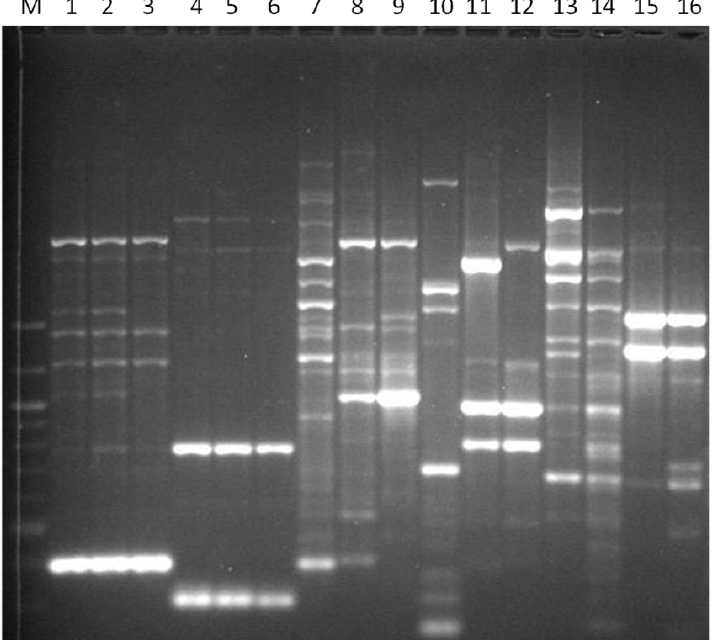
Figure 8. RAPD profiles generated with primers R5 (lanes 1–3, 7–9, and 13–14) and RF2 (lanes 4–6, 10–12, and 15–16). M: 100 bp DNA marker; 1, 4: H. uvarum Hu P12; 2, 5: H. uvarum Hu N10; 3, 6: H.